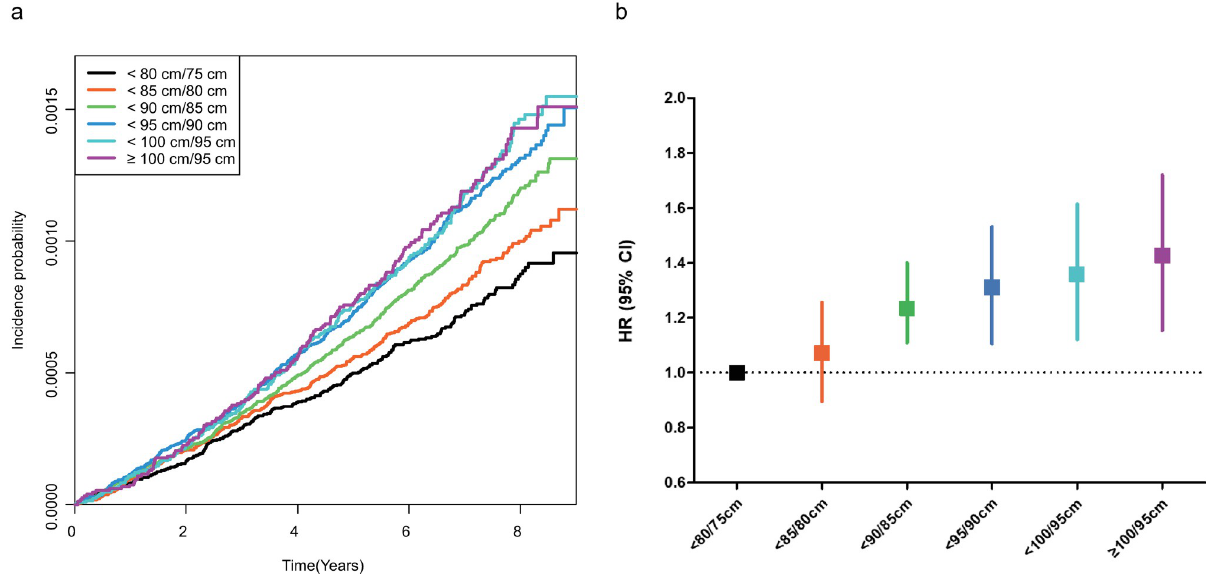
Fig 2. Associations between waist circumference and the risk of glioma. ( a ) Kaplan-Meier estimates of the cumulative incidence of glioma. The analysis was performed in an unadjusted model and the P value by log-rank test was < .001 ( b ) Adjusted hazard ratios for glioma according to waist circumference. Hazard ratios were adjusted for age, sex, smoking status, alcohol consumption, household income, body mass index, diabetes duration, number of oral hypoglycemic agents, and insulin use. CI, confidence interval; HR, hazard ratio.